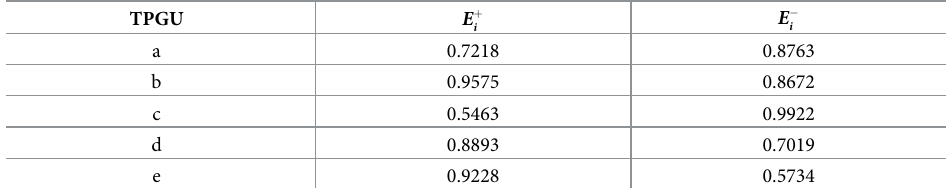
Table 7. The proximity of ideal solution.